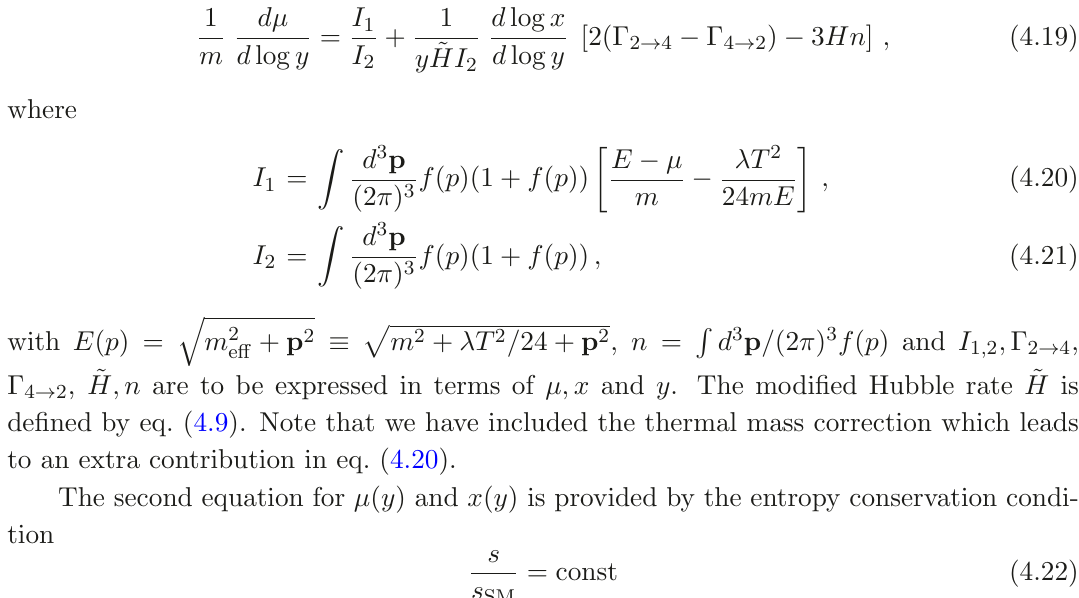
figure 5. The corresponding freeze-out temperature is T f = 1 . 2 GeV with m = 1 GeV, which makes the freeze-out regime